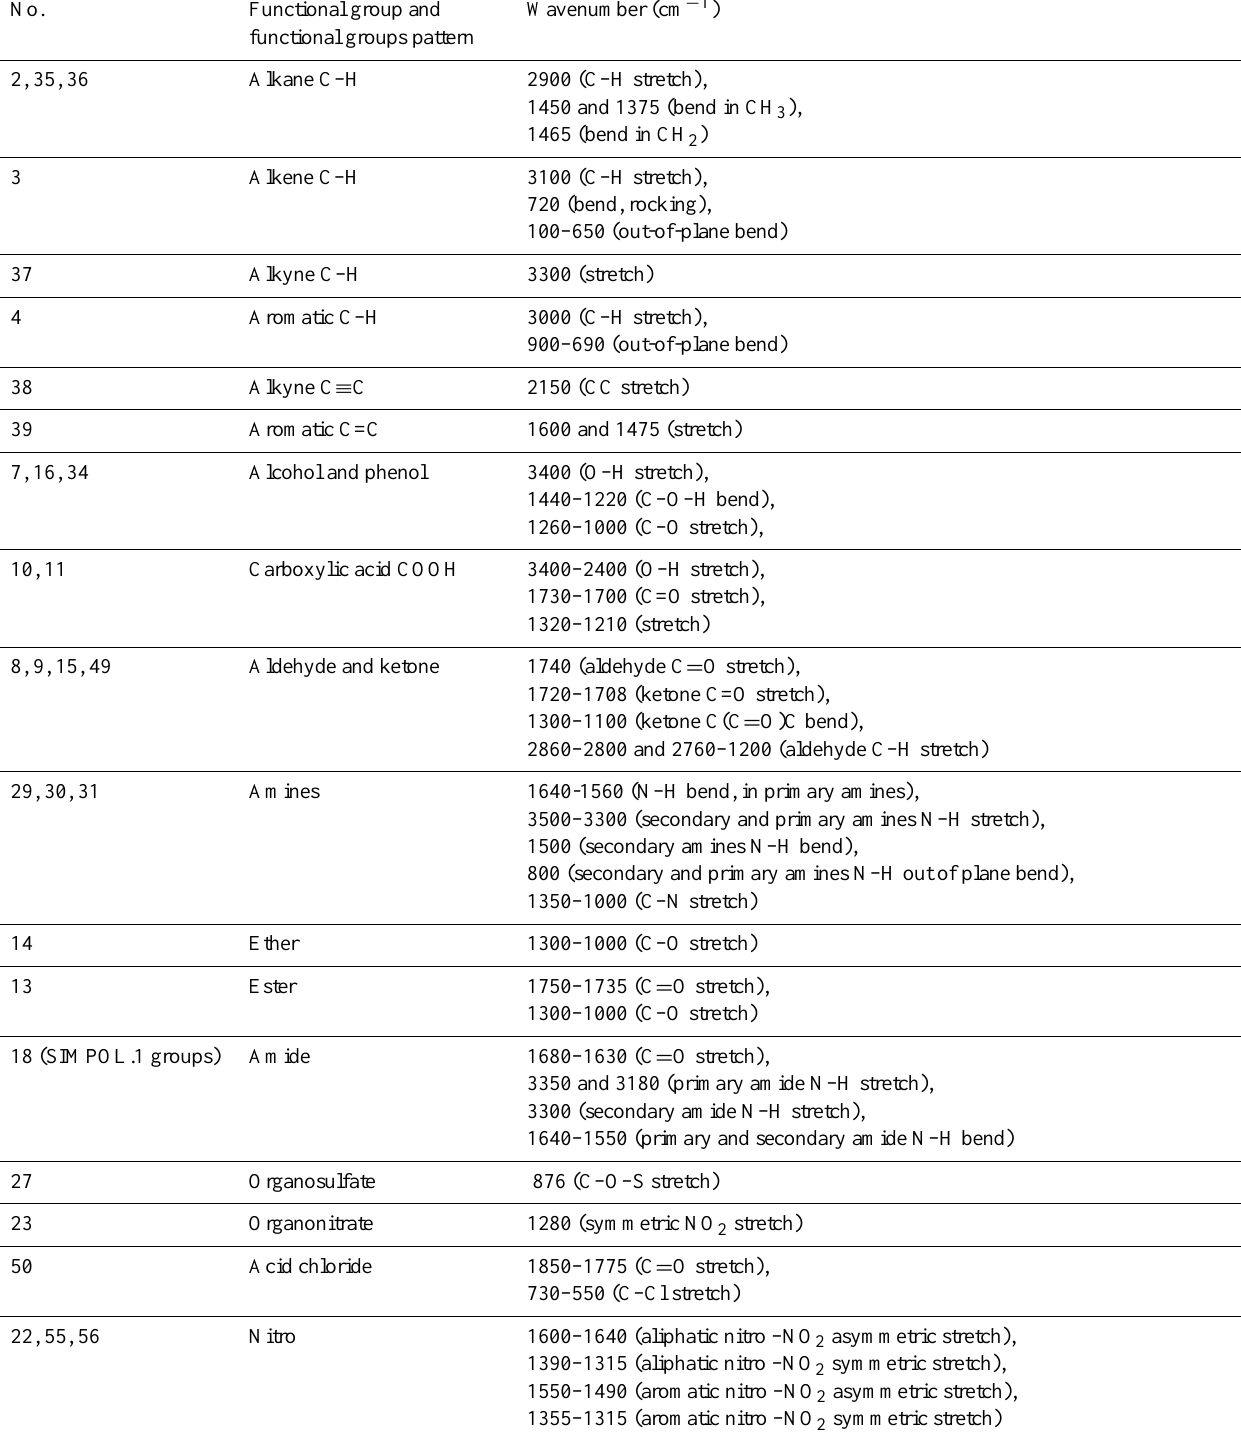
Table 4. Absorption bands in the infrared region of different FGs and the correspondence in Table